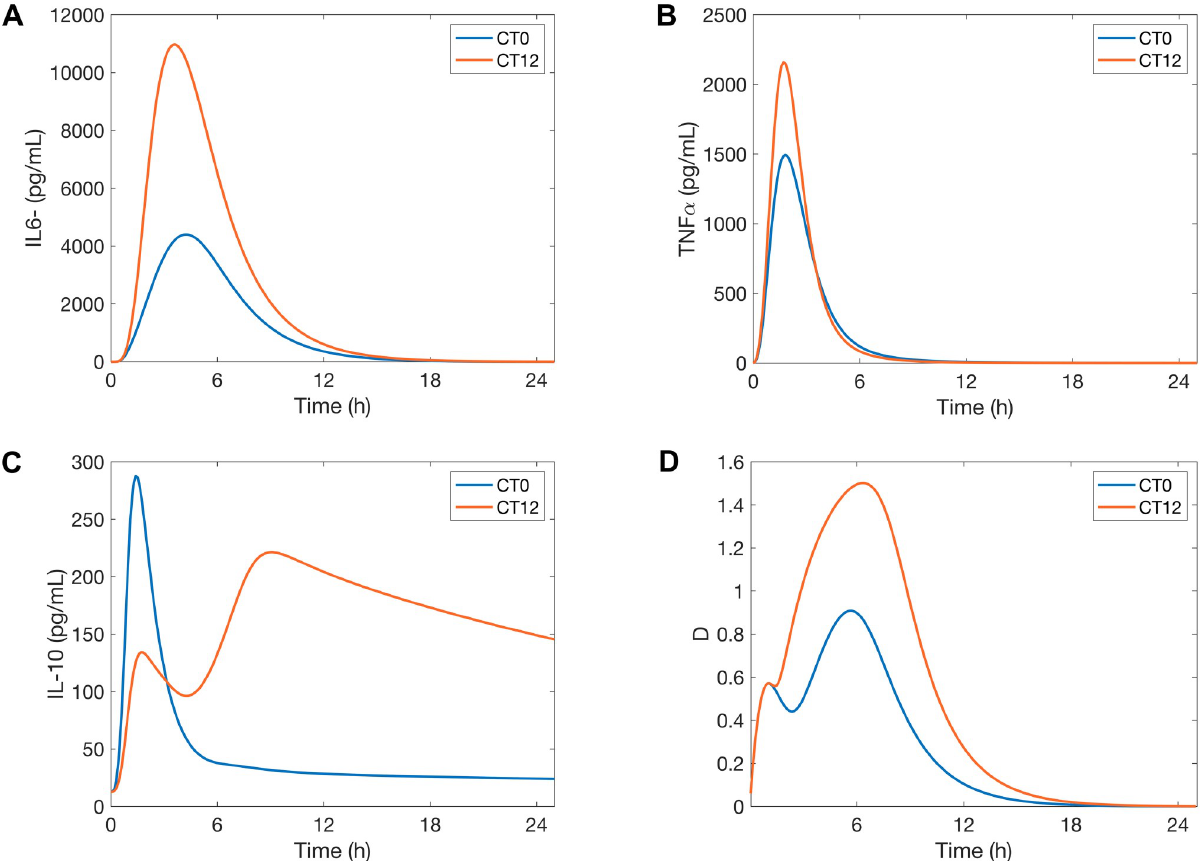
Fig 5. Inflammatory response after infection at CT0 and CT12. Model simulations of the time course of IL-6 , TNF- α , IL-10 and the damage marker for the control model in response to endotoxin dose 3mg/kg administered at CT0 and CT12.